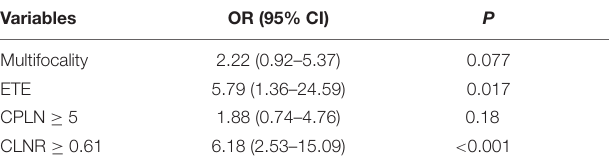
TABLE 3 | Predictive factors of lateral multiple-level metastasis in PTMC